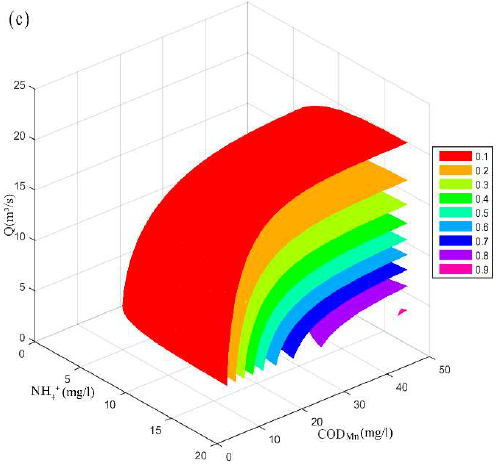
Figure 6. The contour plots and contour surface: ( a ) P U